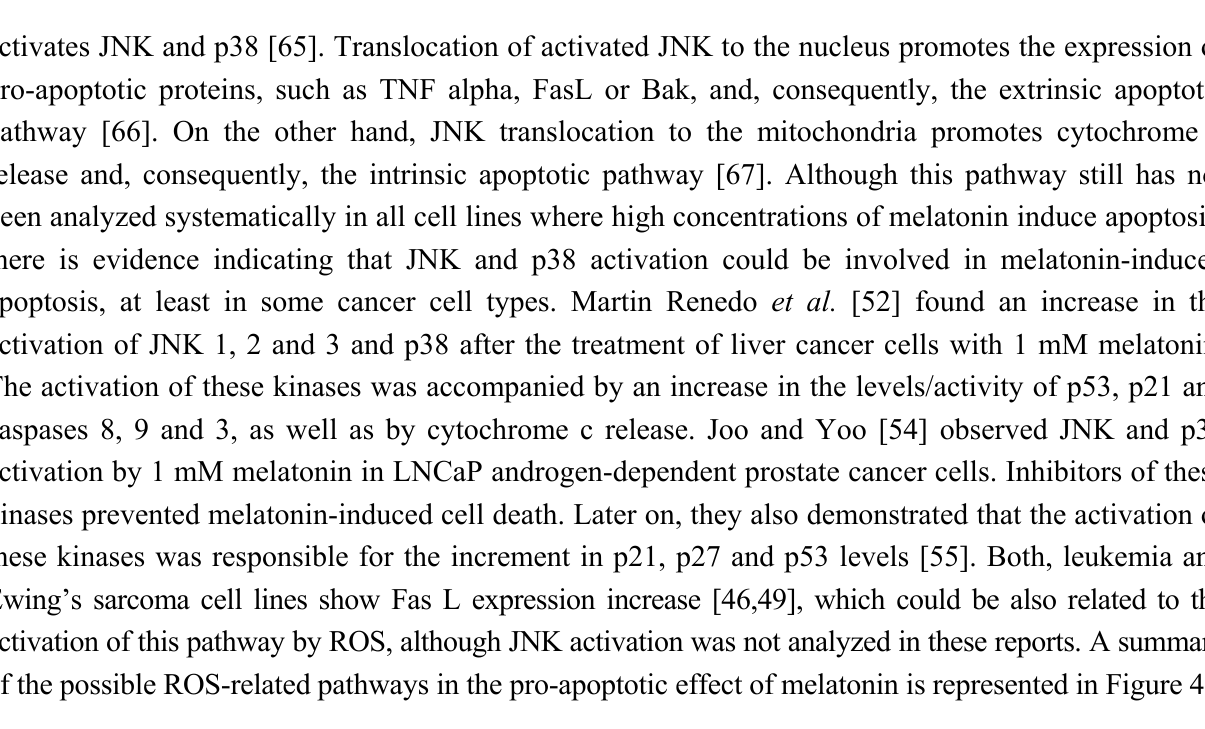
Figure 4. Roles of ROS in apoptosis. * Affected by